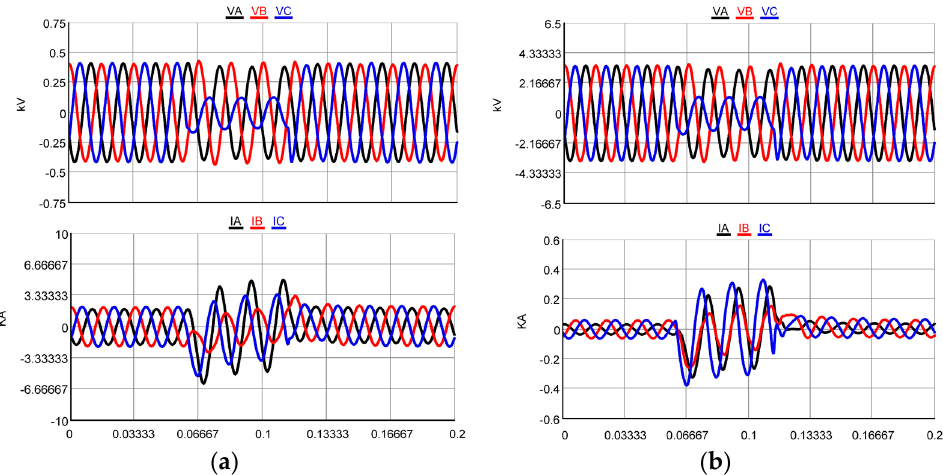
Figure 9. Single line-to-ground fault applied at bus 6 in the transmission system of the testbed: ( a ) instantaneous voltage and current at bus 634; ( b ) instantaneous voltage and current at bus 680.